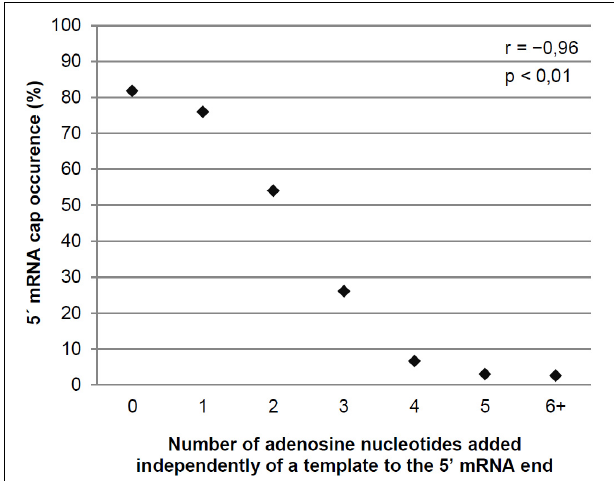
FIGURE 3 | The degree of non-templated 5 (cid:48) mRNA polyadenylation negatively correlates with the proportion of 5 (cid:48) mRNA caps in pGKL transcripts. Transcripts were divided into individual groups ( Supplementary Table S6 ) based on their number of adenosine nucleotides added independently of a template to the 5 (cid:48) poly(A) leader. The plot represents the percentage of sequences containing the 5 (cid:48) mRNA cap in each group. The number of sequences containing the 5 (cid:48) mRNA cap in transcripts with six or more non-templated adenosine nucleotides was very low ( Supplementary Table S6 ); therefore, these transcripts were combined into a single group. The Pearson correlation coefficient value ( r ) is shown. The results are statistically significant at the p < 0.01 level. In total, 350 sequences obtained by 5 (cid:48) RACE-PCR were used for this